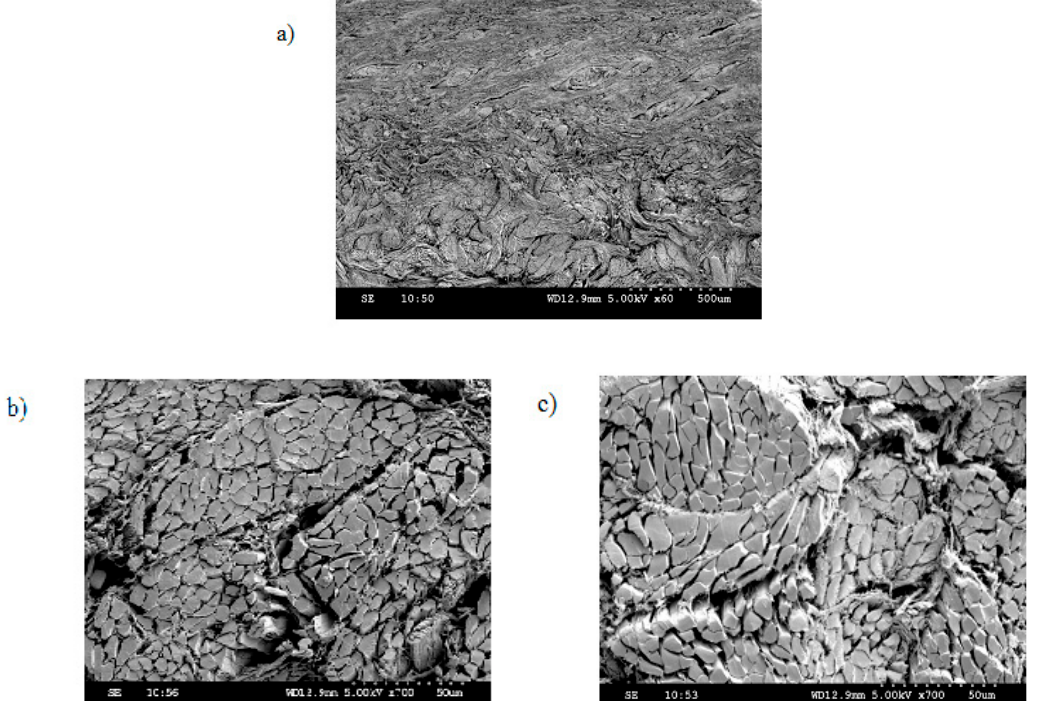
Figure 5. Leather sample cross sections at low magnification ( a , × 60) and higher magnification ( b–c , × 700).